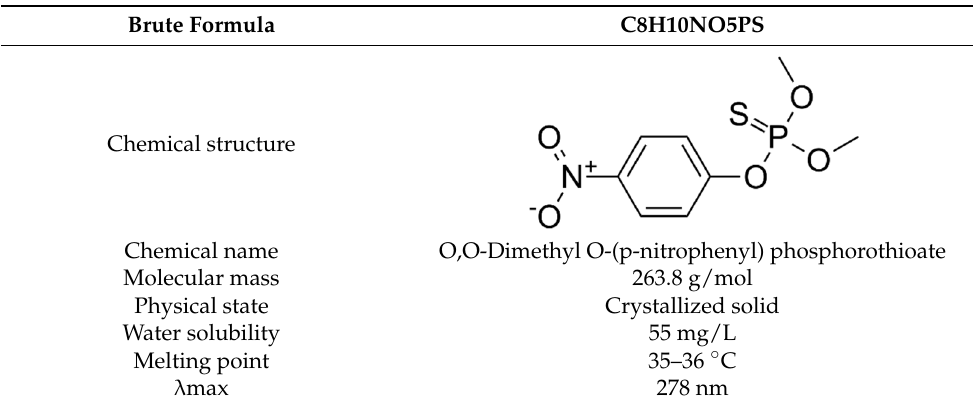
Table 4. Physicochemical properties of parathion-methyl [51].